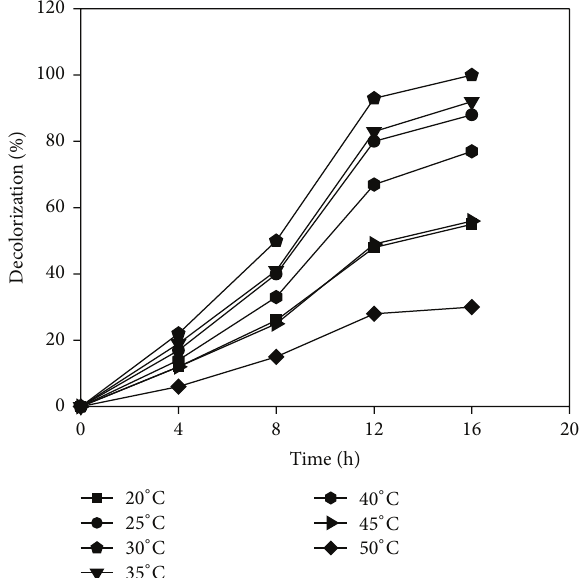
Figure 5: Effect of temperature on decolorization of Reactive Violet